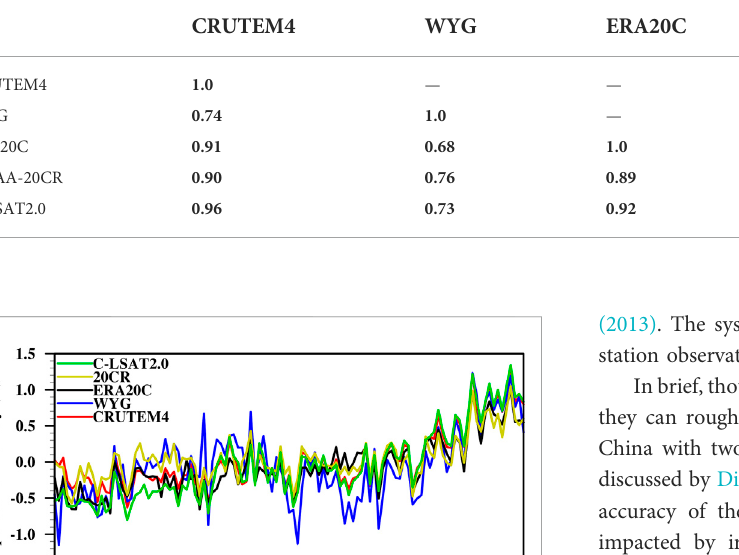
TABLE 2 Correlation analysis of fi ve datasets from 1900 to 2015 (values in bold are signi fi cant at the 95%